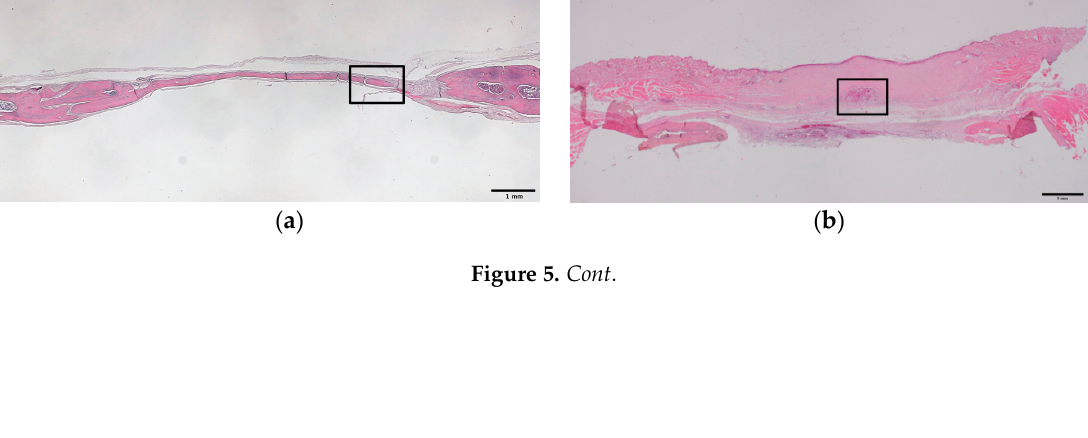
( h ) Figure 5. Histological images (hematoxylin and eosin staining) at eight weeks after operation. ( a ) unfilled defect in the control group (bar = 1 mm). ( b ) AL (bar = 1 mm), ( c ) AL/HA (bar = 1 mm), ( d ) and AL/HA/SF (bar = 1 mm) composites. ( e – h ) are magnified views of the boxed areas in ( a – d ) (original magnification 100×, bar = 100 µm).